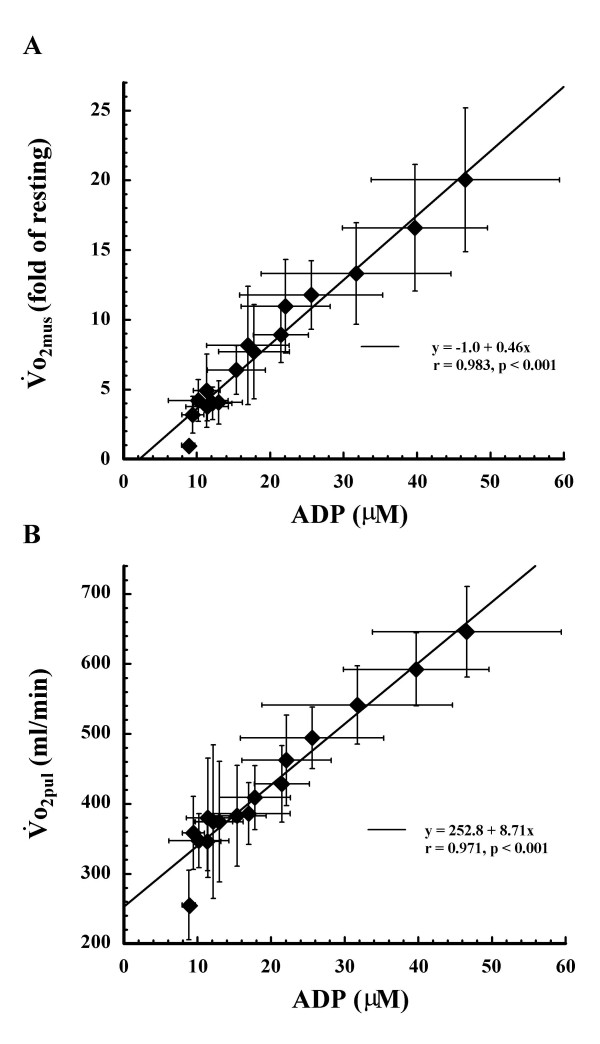
Relationships between muscle ADP and o2mus, muscle ADP and o2pul. Relationships between (A) averaged muscle ADP and o2mus and (B) averaged muscle ADP and o2pul. Values shown are means ± SD of 5 subjects.